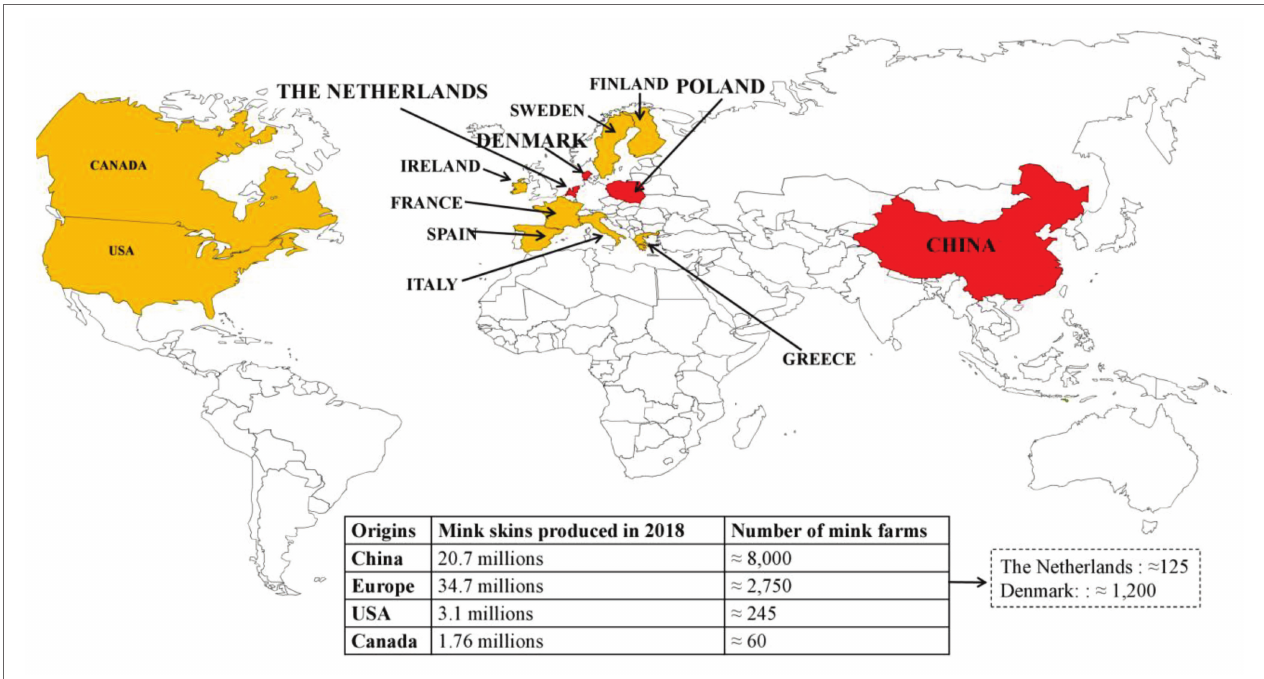
FIGURE 1 | Distribution of the largest producers and the main mink farms worldwide. The four biggest producers are in red, the following ones are in